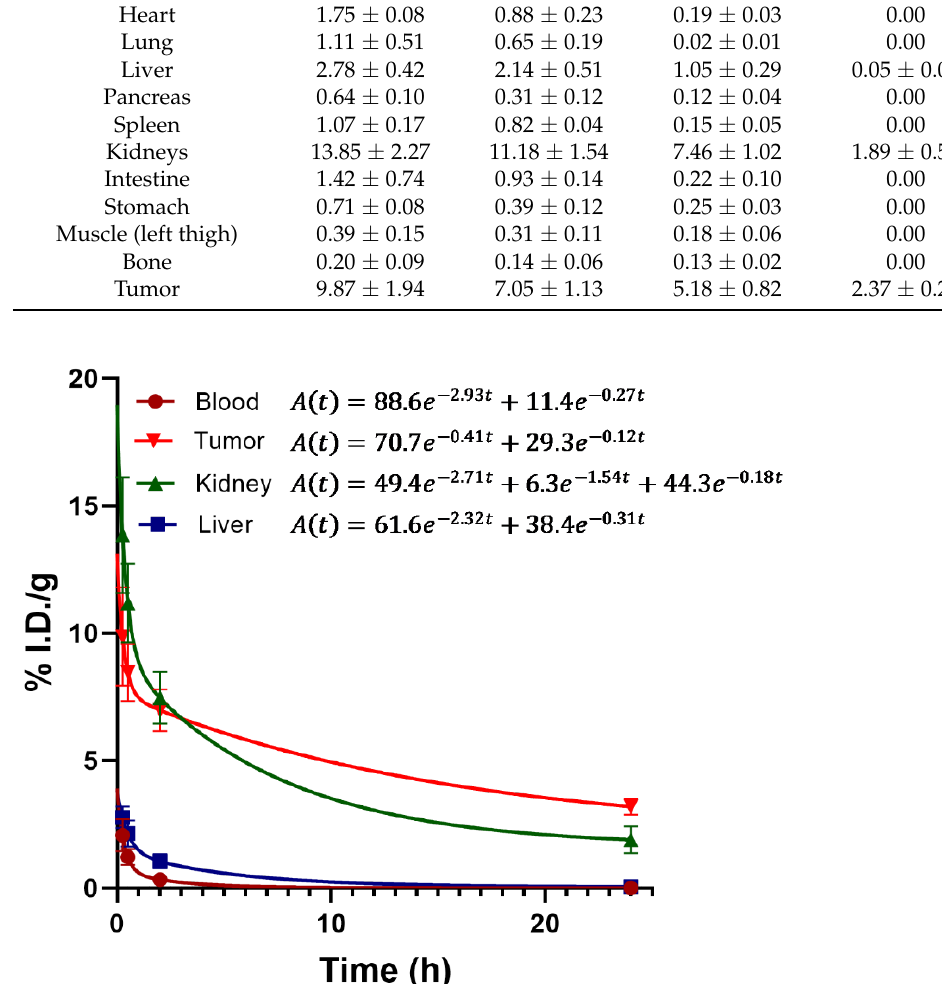
Figure 6. Biokinetic models of 99m Tc-iFAP in the four main target tissues: blood, tumor, kidney and liver. As can be observed, blood showed the fastest elimination and tumor, the lowest.